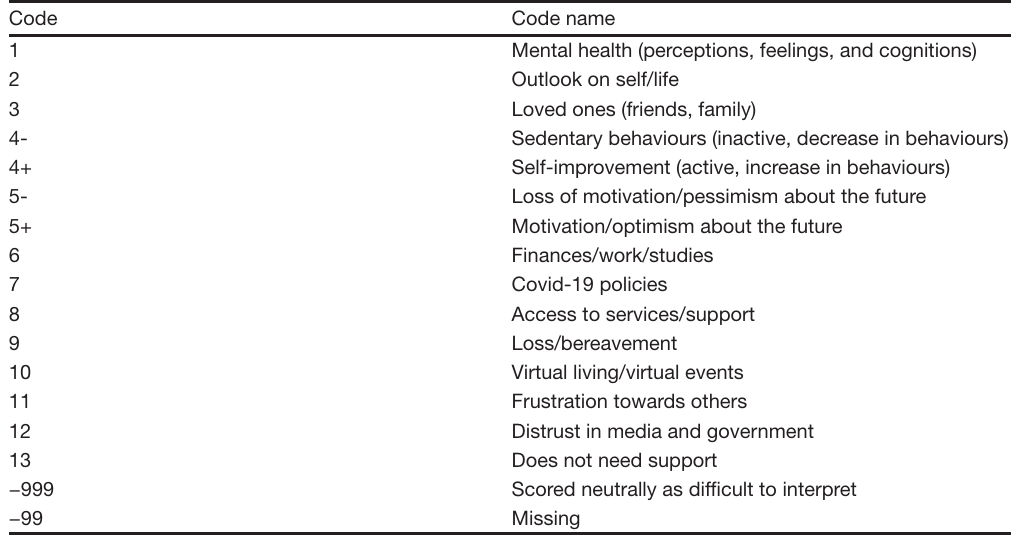
Table 2. Thirteen codes derived from participant responses